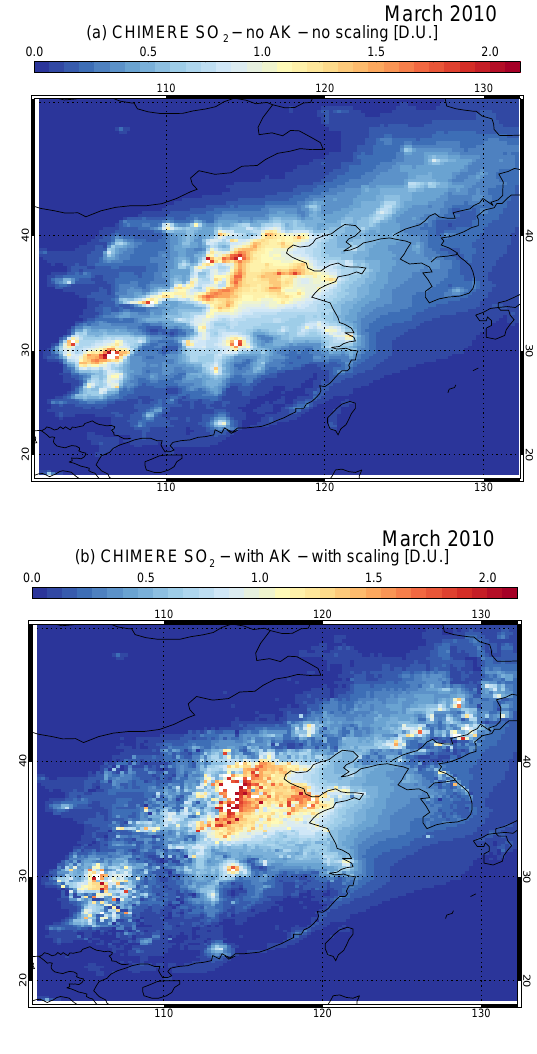
Figure 3. The March 2010 SO 2 columns in D.U. as integrated in height from the original CHIMERE model ppb levels: (a) without rescaling to the effective pressure and without convolution with the OMI AKs; (b) with rescaling and with convolution with the OMI